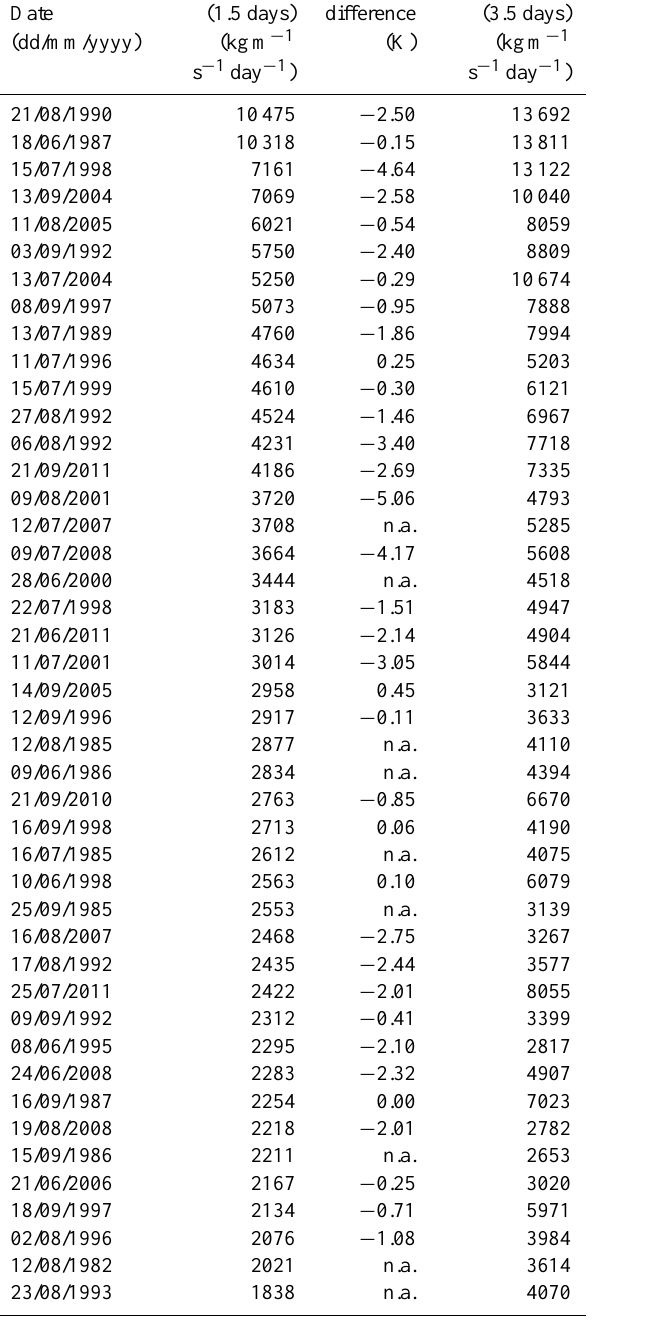
Table A1. Wind impulse per day for BE summer (June to Septem- ber) surveys between 1982 to 2012. The sea surface temperature (SST) difference between Kiel lighthouse and all BE surveys is given for the period 1988 to 2012 only. For some surveys the SST difference could not be derived (indicated by n.a., not available).